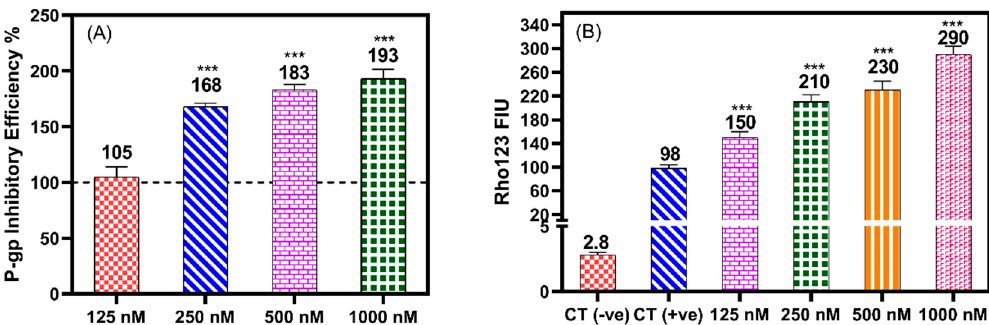
Figure 5. The effect of different concentrations HAA 2021 on the P-gp transporter protein in MCF7/ADR cells. ( A ) The Rho123 efflux assay. Data expressed as mean ± SD of P-gp inhibitory efficiency compared with verapamil as a positive control (100%) as represented as the dashed line to show the decrease of efflux. ( B ) Accumulation assay. Rho123-FIU was used to compare the Rho123 fluorescence accumulation by HAA 2021 with the untreated control (CT − ve), verapamil positive control (CT +ve) in MCF7/ADR, to show the increase of doxorubicin accumulation. *** p < 0.001 indicated the significant difference of treated cells compared with